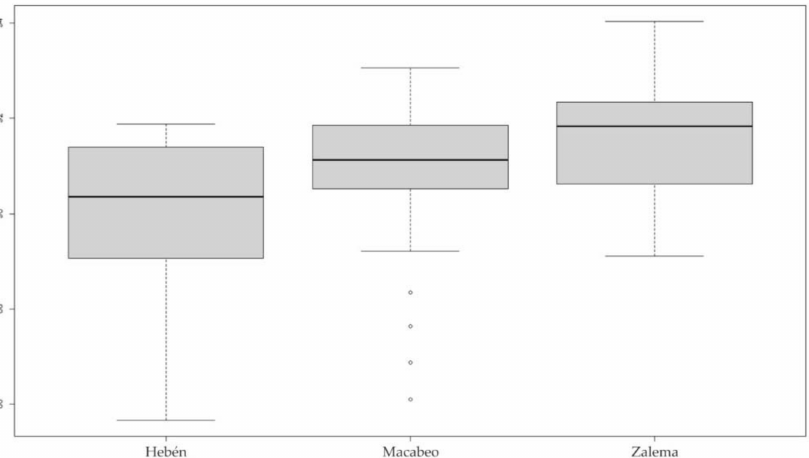
Figure 11. Box-plot representations showing the distribution of J index values in the cultivars Heb é n, Macabeo and Zalema with the Heben model.